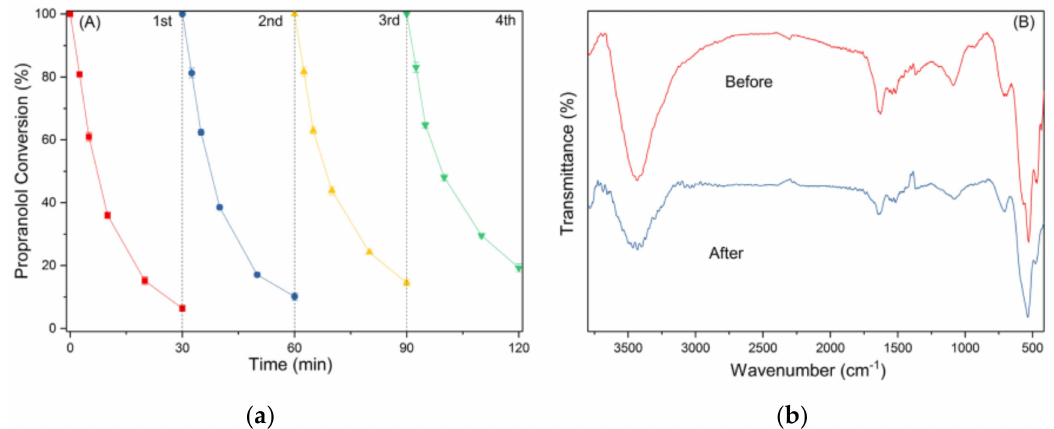
Figure 16. ( a ) Reutilization cycles for PRP degradation; ( b ) FT-IR spectra of Co 2 CPc@NOMS-2 before and after the reuti- lization cycles. Adapted with permission from ref. [77]. Copyright 2019